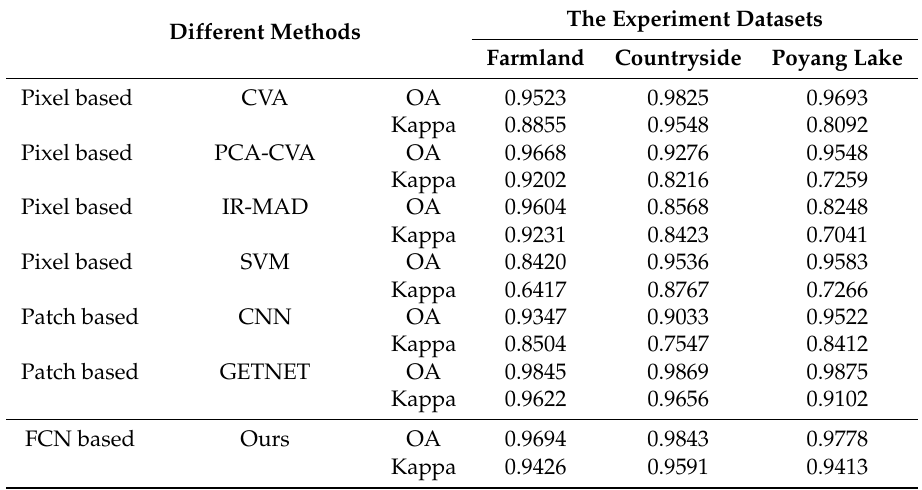
Table 2. The overall accuracy and kappa coefficients of the proposed method and the other six change detection methods for three